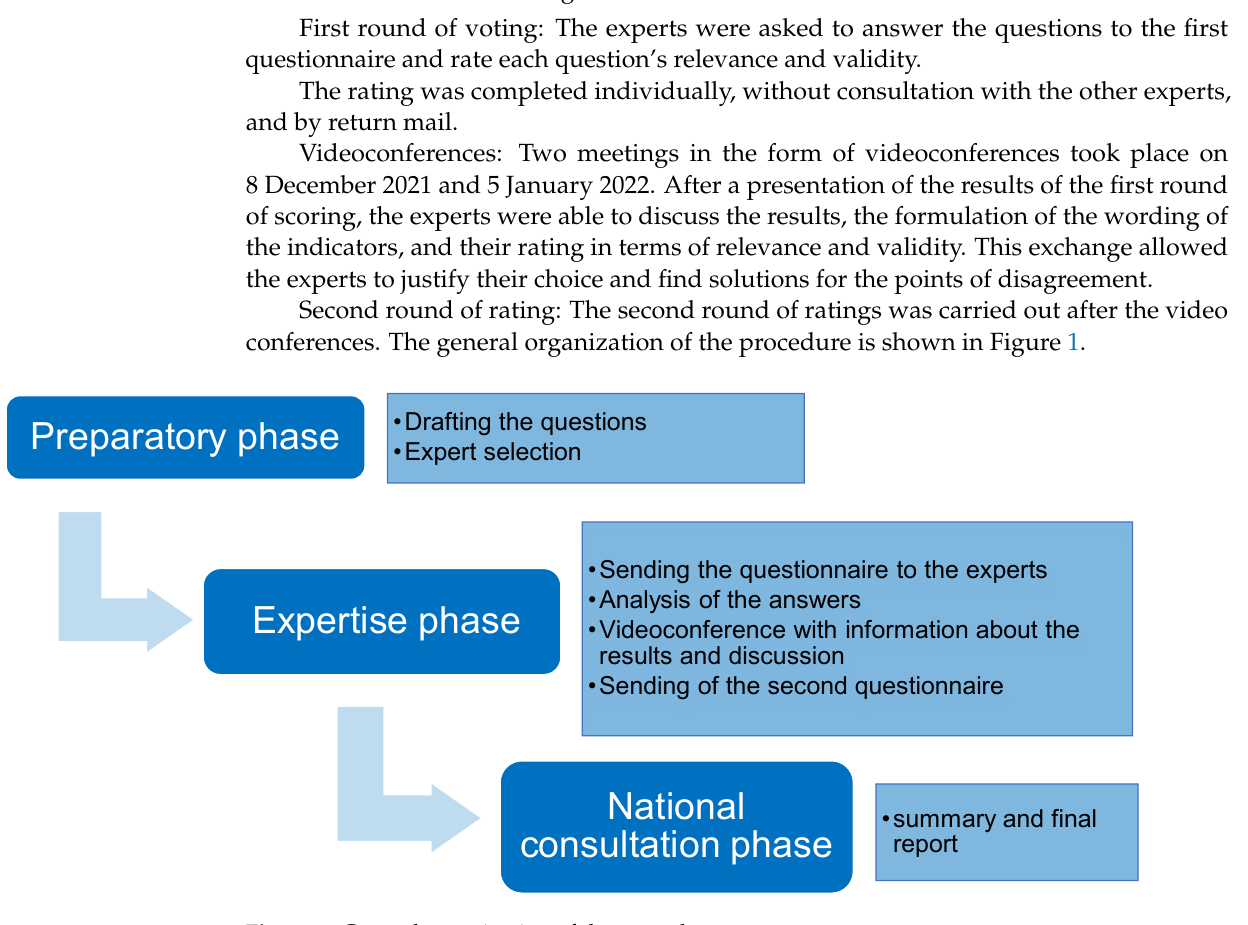
Figure 1. General organization of the procedure.